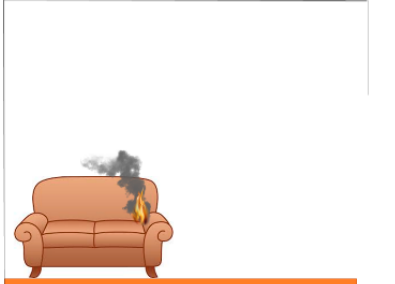
Figure 2. Illustration of fire development in compartments.